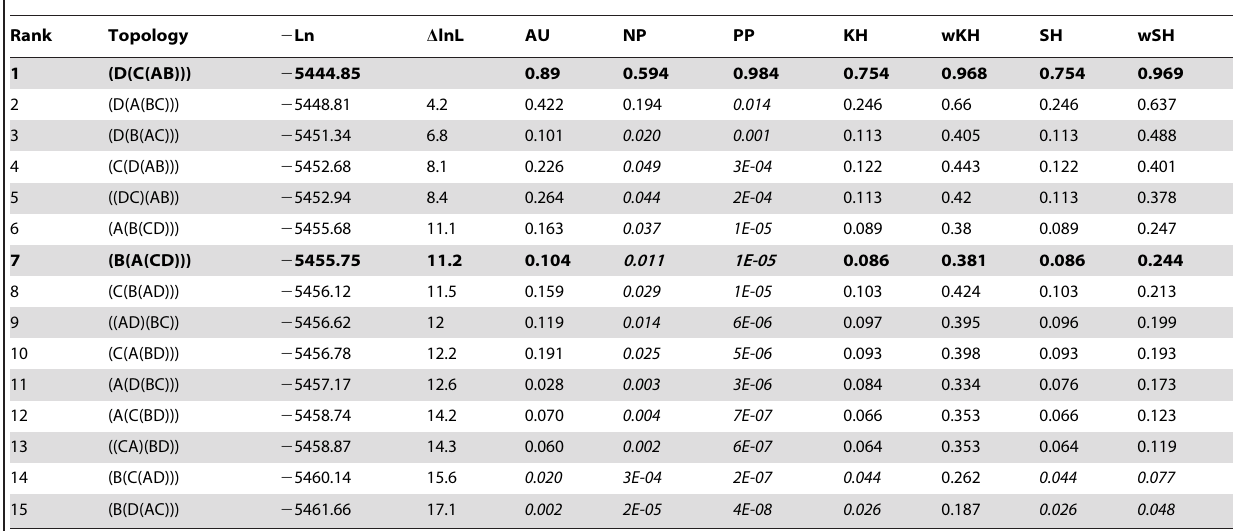
Table 3. Col cluster duplication topology